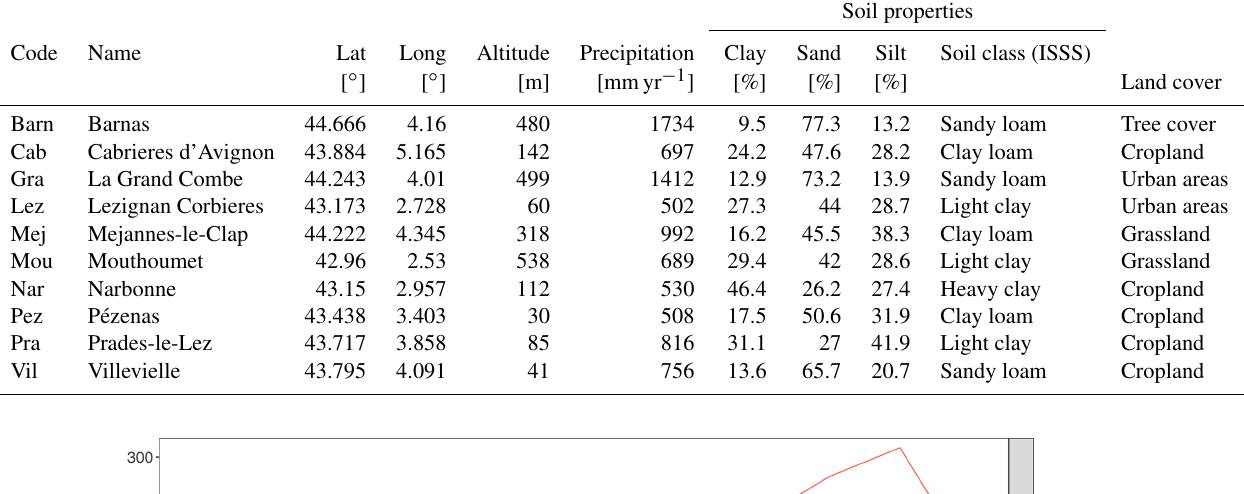
Table 1. Station characteristics.